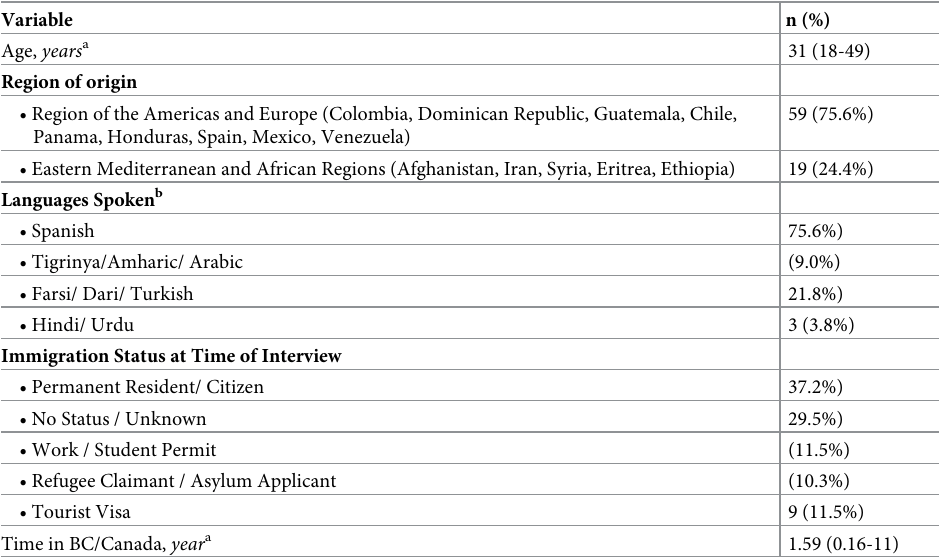
Table 1. Im/migrant women: Participant characteristics (N =